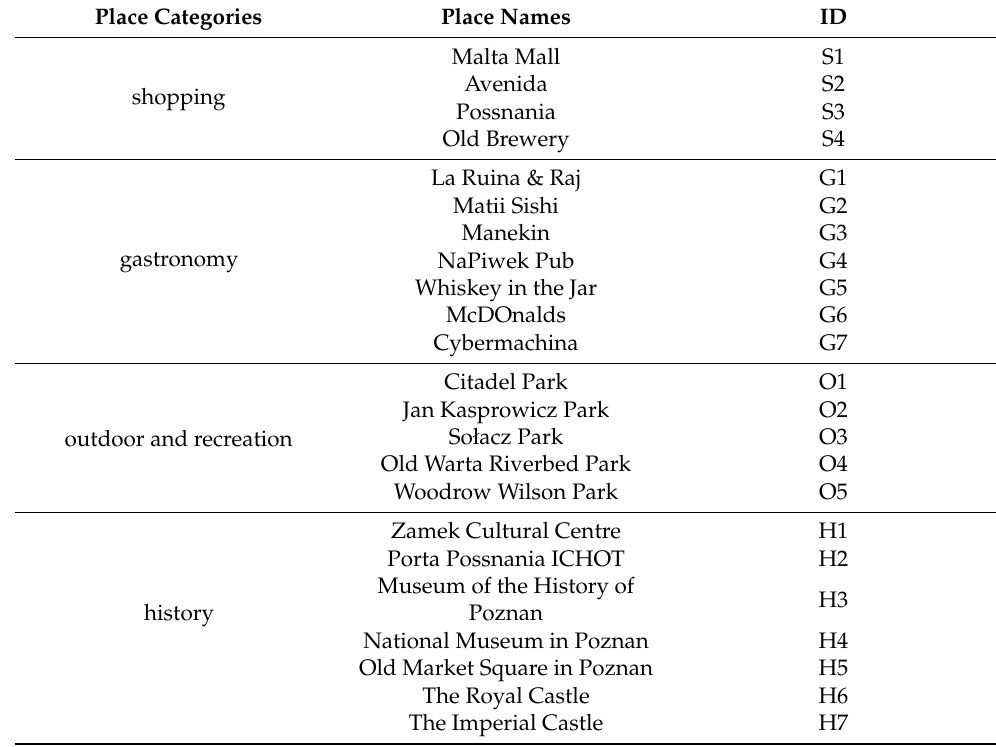
Table 1. Places selected into the analysis within context of functional